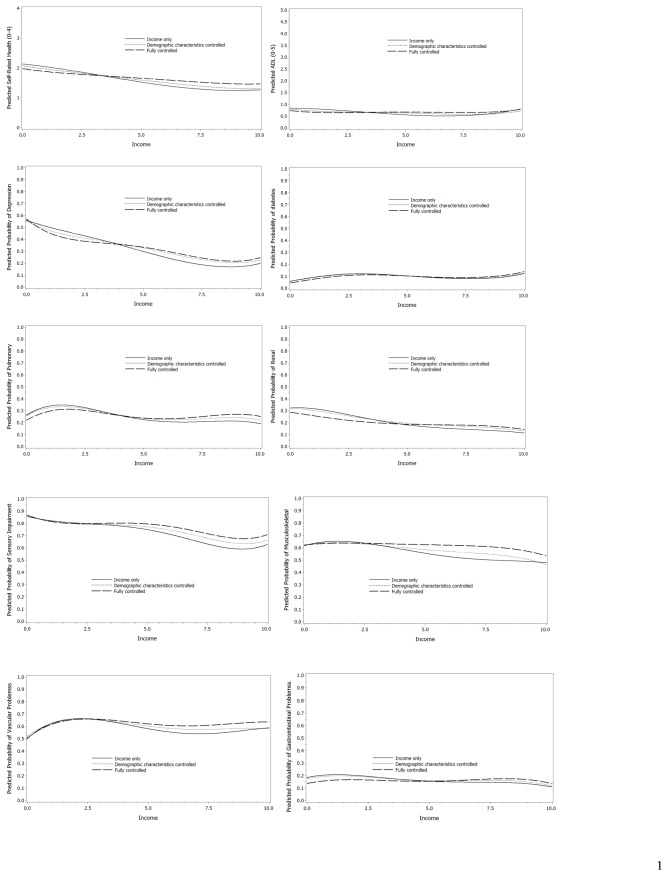
Health conditions (depression, diabetes, pulmonary disorders, renal disorders, sensory impairment, musculoskeletal disorders, cardiovascular disorders, gastrointestinal disorders) and health status (self-rated health, functional status), plotted against household income measured as a multiple of the minimum wage (MW) adjusted for number supported and for economies of scale.Lines show results controlling for income only, income + demographic characteristics, and income, demographic characteristics and health conditions other than the condition under consideration. For specific health conditions values on the vertical axis indicate predicted proportion with the disorder; for self-rated health 0 = excellent health, 4 = very poor health; for functional status the scale indicates predicted number of impairments in activities of daily living (possible range 0-5). The value on the horizontal axis is household income adjusted for number supported.